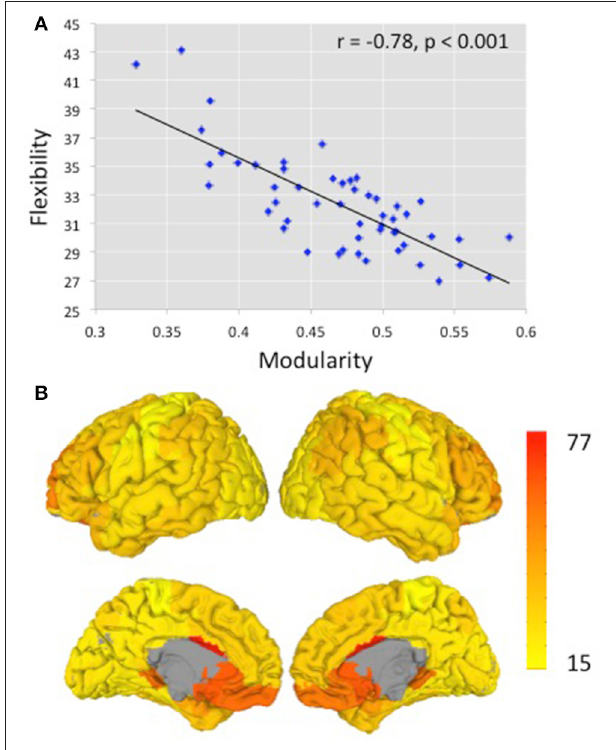
FIGURE 2 | (A) The relationship between modularity and flexibility across 52 participants. r = − 0.78 ( p < 0.001). The y-axis shows the averaged flexibility values over all Brodmann areas across subjects. The x-axis shows modularity values, the excess probability of connections within the modules, relative to what is expected at random (B) Illustration of flexibility measures over cortical structures. Brodmann areas with higher flexibility are shown in red and those with lower flexibility are shown in